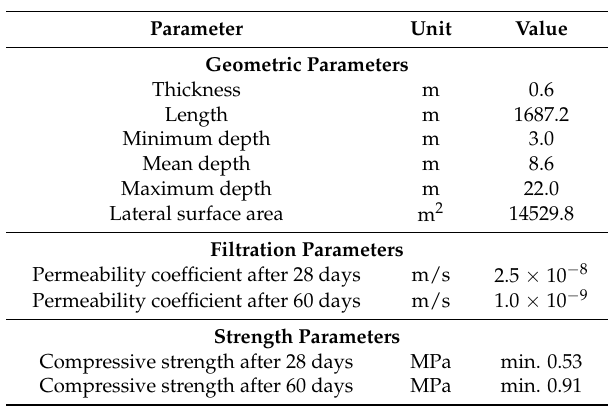
Table 2. Characteristics of the vertical